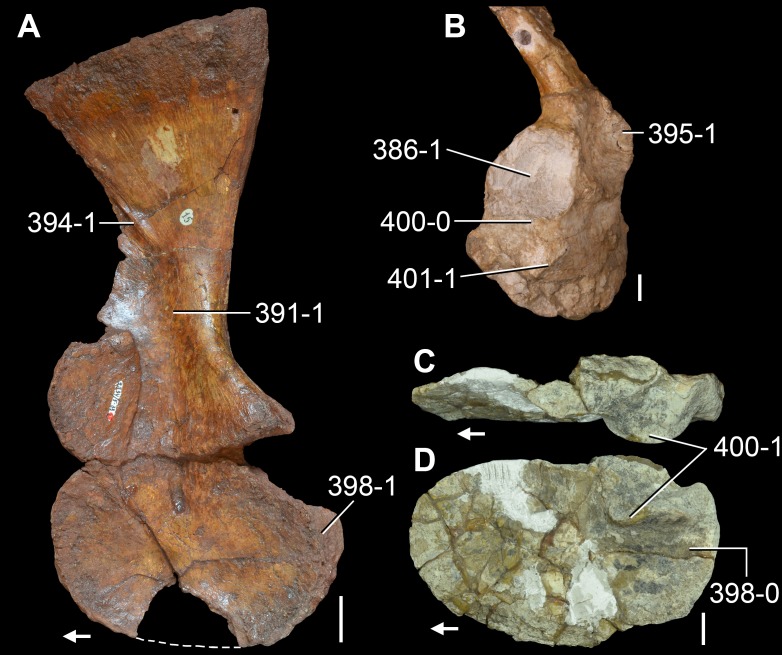
Scapulae and coracoids of Triassic archosauromorphs in (A) medial, (B) posterolateral, (C) dorsal, and (D) lateral views.(A) Right scapula and coracoid of Garjainia prima (PIN 2394/5-33); (B) right scapula and coracoid of Gualosuchus reigi (PULR 05); and (C, D) left coracoid of Pamelaria dolichotrachela (ISI R316/1). Numbers indicate character-states scored in the data matrix and the arrows indicate anterior direction. Scale bars equal 2 cm in (A) and 1 cm in (B-D).